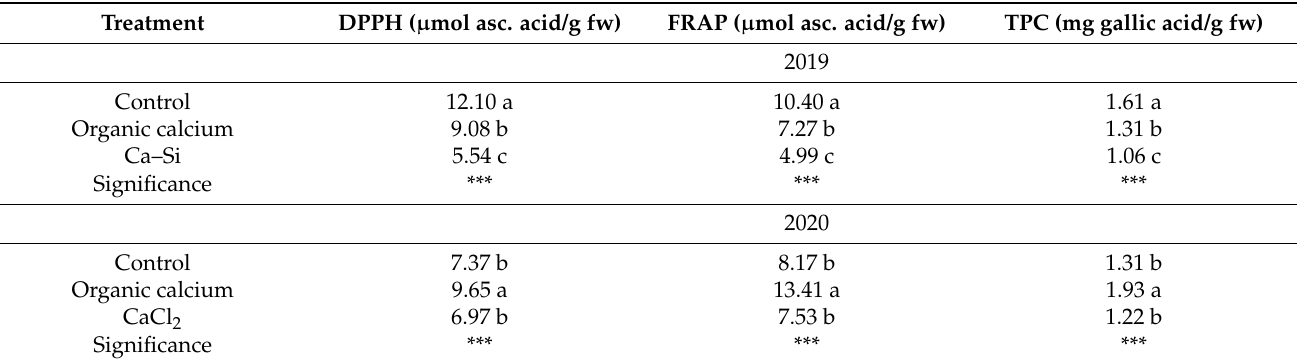
Table 3. The effect of Ca formulation on the total antioxidant activity (DPPH and FRAP assays) and total phenolic content (TPC) at the Kato Lehonia orchard.